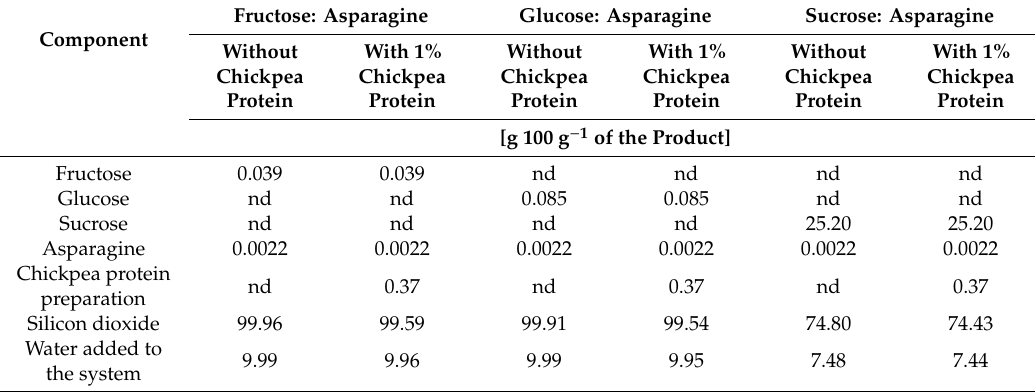
Table 1. Qualitative and quantitative composition of amino acid: carbohydrate model